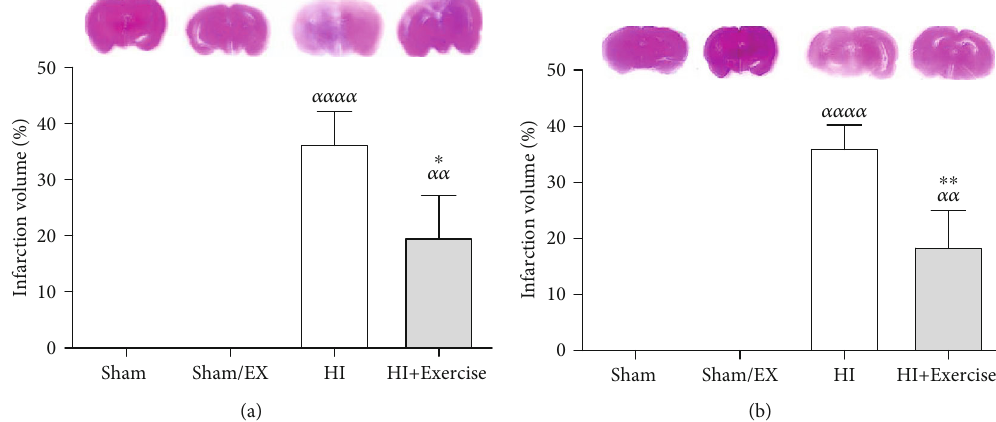
Figure 7: E ff ect of maternal exercise during pregnancy, on the infarction volume of female (a) and male (b) pups. HI: hypoxia-ischemia. αα P < 0 : 01 , αααα P < 0 : 0001 as compared with the sham and sham/EX. ∗ P < 0 : 05 , ∗∗ P < 0 : 01 as compared with the HI. Data are expressed as the mean ± S : E : M : ( n = 10 ).